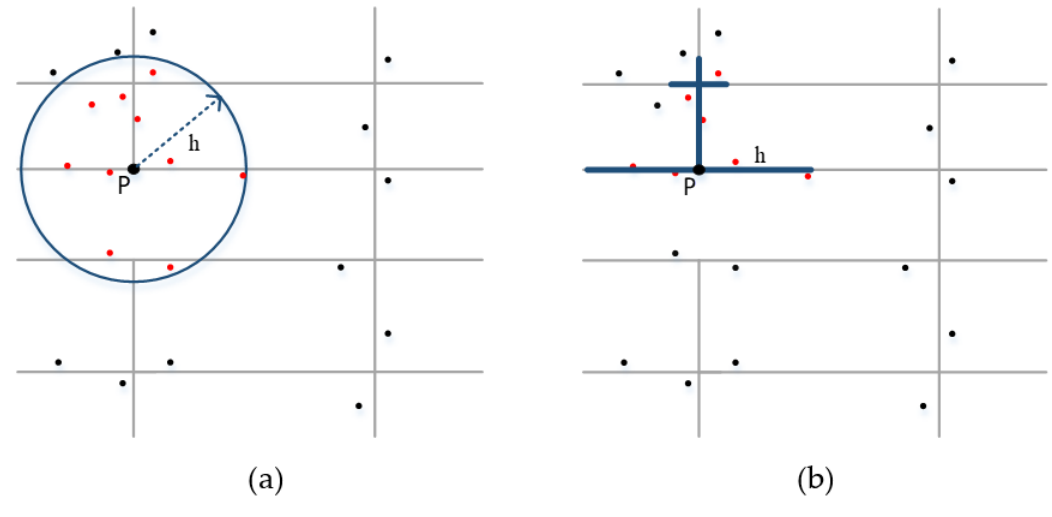
Figure 2. The comparison between planar kernel density method ( a ) and network kernel density method ( b ): The point P represents a sample point on the street network; h is the bandwidth; and dot points represent events, among which red dots represent events that fall within the catchment of P.